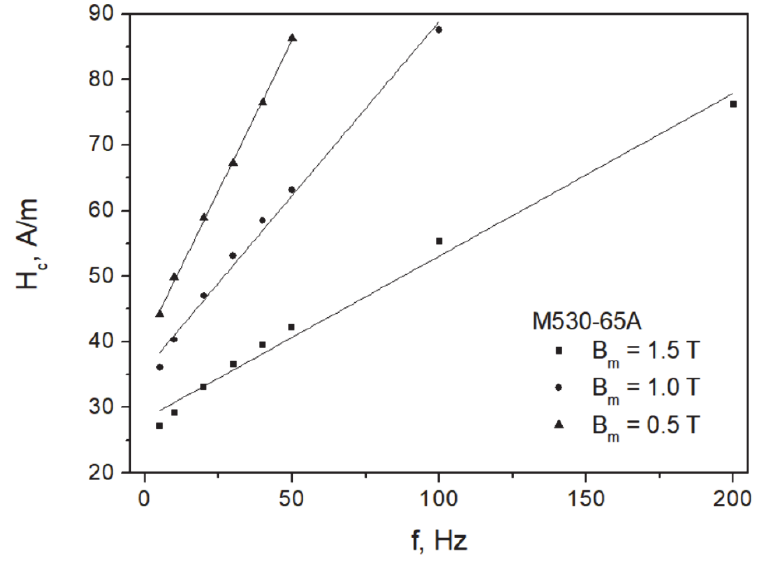
Figure 5. Measured H c = H c ( f ) dependencies for the M530-65A grade. Figure 5. Measured )( cc fHH  dependencies for the M530 ‐ 65A grade. For the dependencies shown in Figures 4 and 5, the values of the adjusted coefficients 2 of determination R exceeded 0.987, thus they were relatively